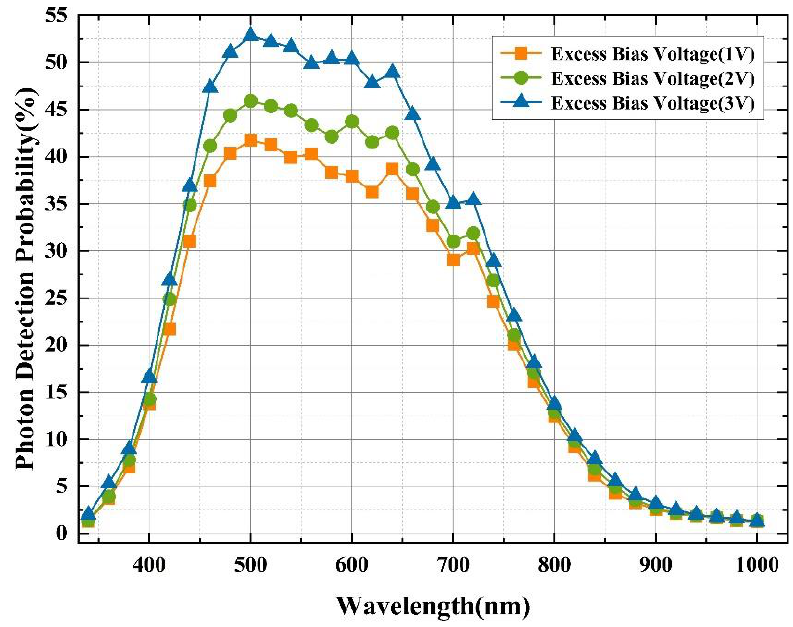
Figure 9. Measured PDP curve of HDEPD device (temperature: 20 °C).